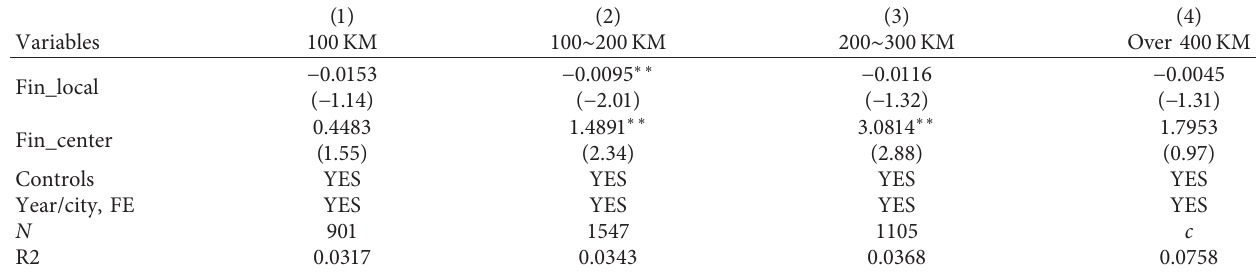
Table 8: Distance